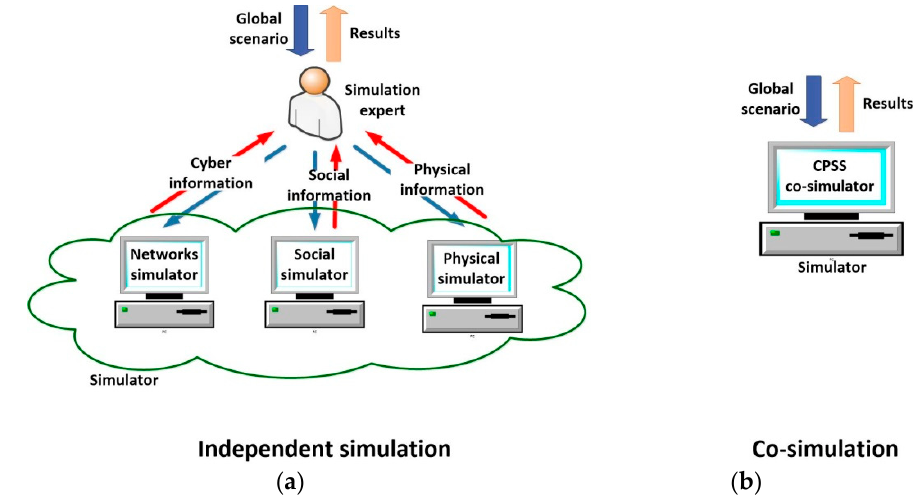
Figure 4. Different simulation paradigms ( a ) Independent simulation ( b ) Co-simulation.